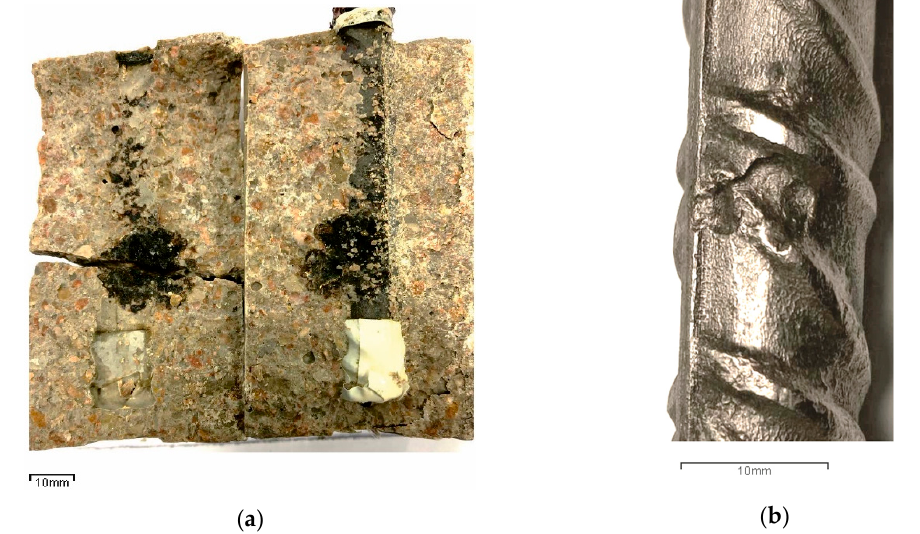
Figure 13. Rebar corrosion in a specimen of concrete C-0. ( a ) Specimen axially split; ( b ) pitting corrosion on the clean rust rebar.